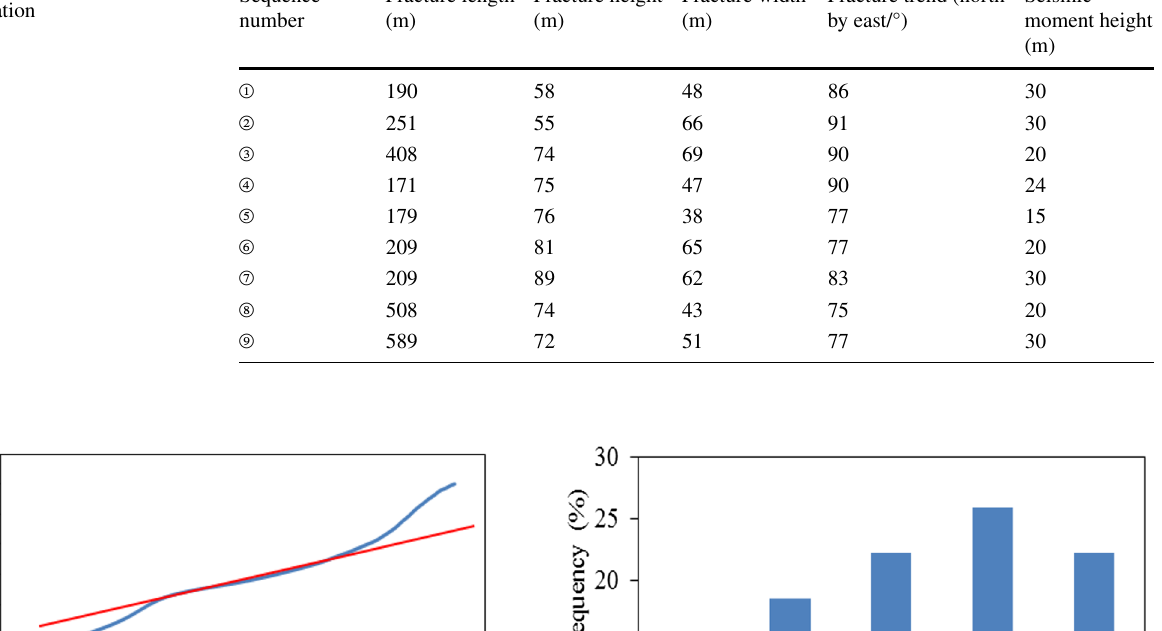
Table 2 Results of microseismic